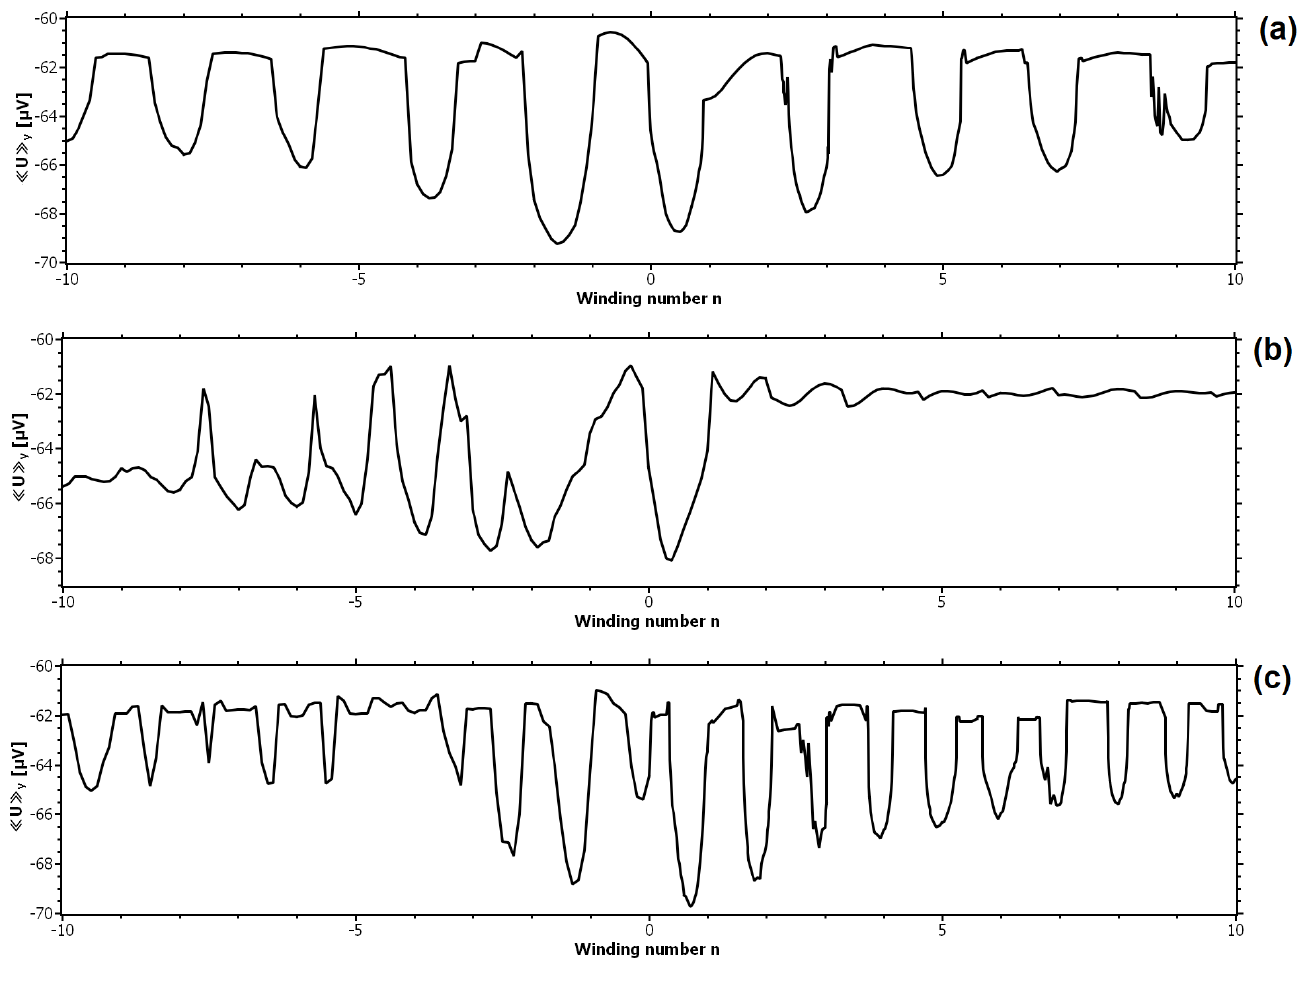
Figure 3. Mean voltage versus winding number for B e = 1.5mT, α 0 = 0.1¯ h / ξ GL , and j e = 7.07GA/m 2 e y . ( a ) The magnetization is symmetrically contracted around the y-axis with α = α s . ( b ) The magnetization is fixed at x = − d /2 with α = α l . ( c ) The magnetization is fixed at x = + d /2 with α = α r